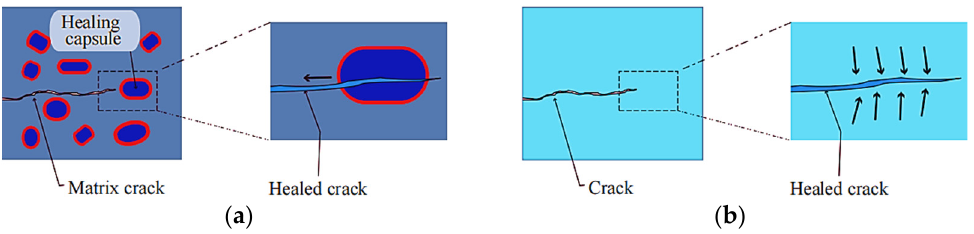
Figure 2. Schematic of ( a ) extrinsic self-healing material and ( b ) intrinsic self-healing material [37].